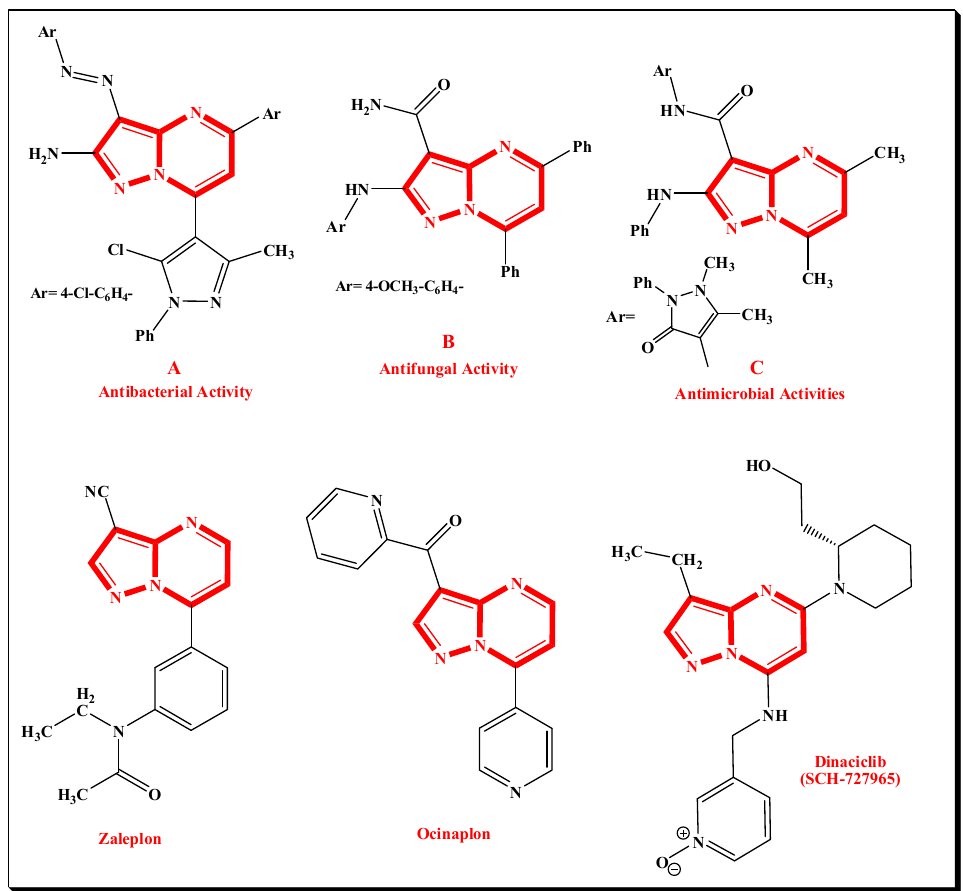
Figure 1. Examples of biological activities of pyrazolo[1,5- a ]pyrimidines and the structures of some drugs.